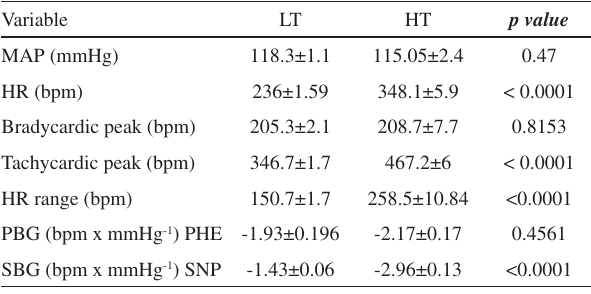
Table 2- Baseline mean arterial pressure (MAP) and heart rate (HR), bradycardic and tachycardic peak, HR range, para- sympathetic (PBG) and sympathetic baroreflex gain (SBG) in HT (n=20) and LT (n=6) groups. Mean±SEM.